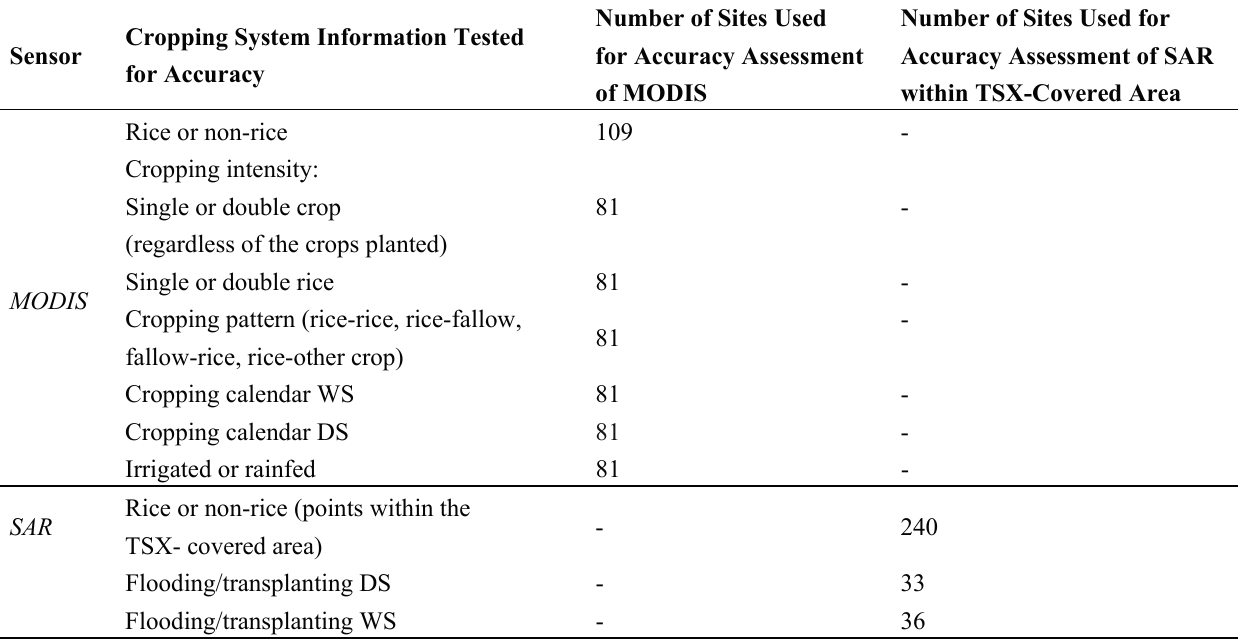
Table 3. Number of rice fields used for the accuracy assessment of rice-based cropping system characteristics and rice area